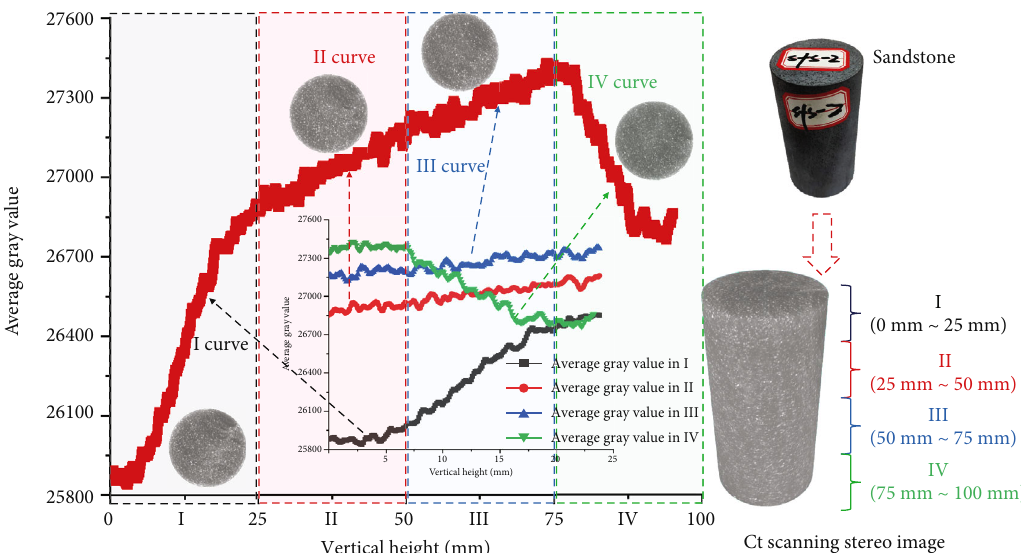
Figure 5: Variation curve of average gray value of intact sandstone.